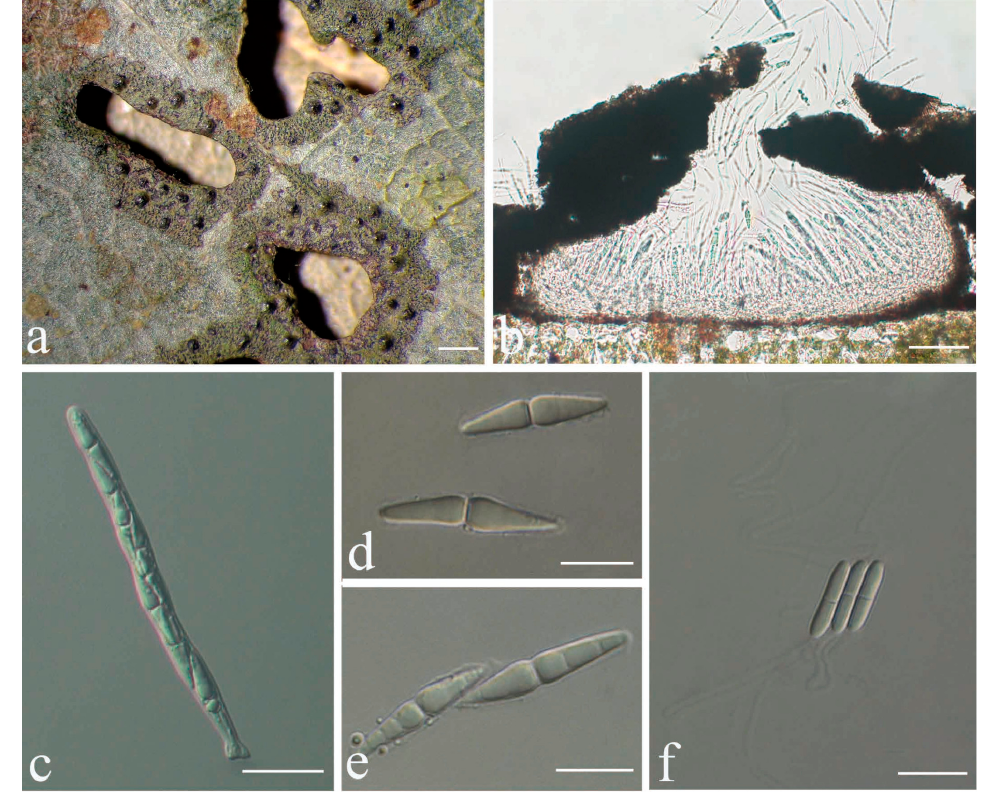
Figure 5. Racoplaca macrospora sp. nov. (holotype, HMAS–L0139274). ( a ) Thallus; ( b ) Perithecia; ( c ) asci; ( d ), ( e ) ascospores; ( f ) macroconidia. Scale bars: ( a ) = 1.5 mm; ( b ) = 50 μ m; ( c ) = 20 μ m; ( d – f ) = 10 μ